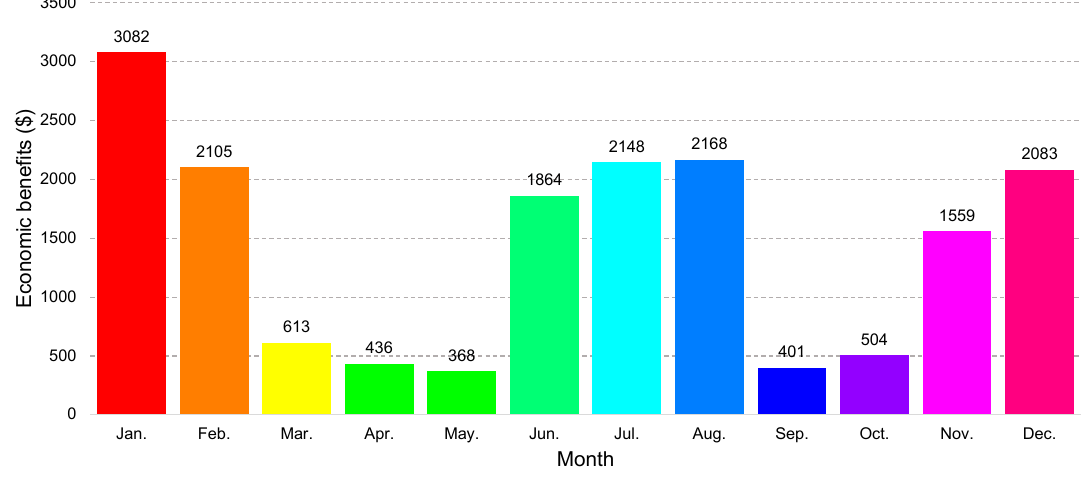
Figure 5. Monthly economic benefits.